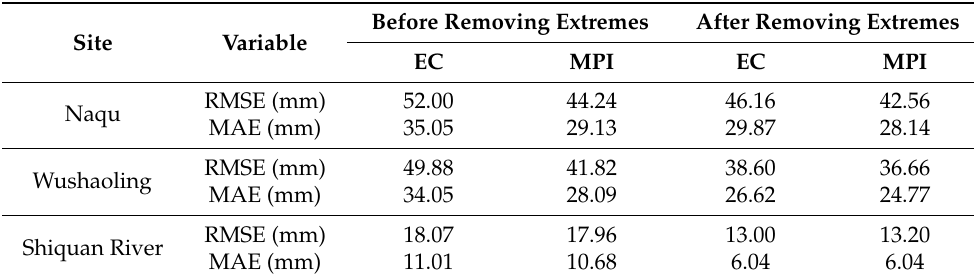
Table 5. RMSE and MAE values before and after the removal of daily precipitation extremes in the control observations at three different sites.